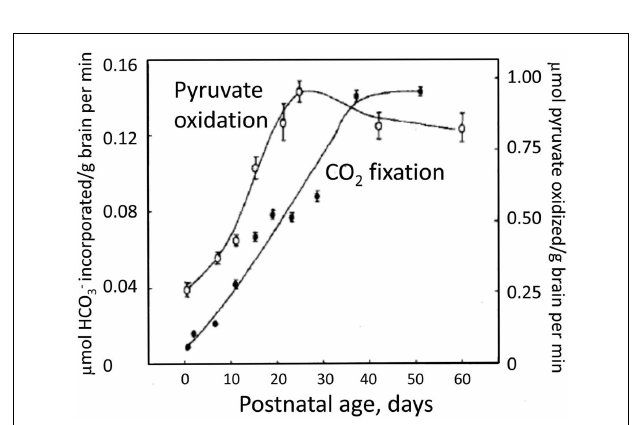
FIGURE 9 | Decarboxylation of [l-14C]pyruvate by pyruvate dehydrogenase and the fixation of HCO − by pyruvate carboxylase in 3 rat brain homogenates obtained from animals of different ages between birth and adulthood. FromWilbur and Patel (1974).